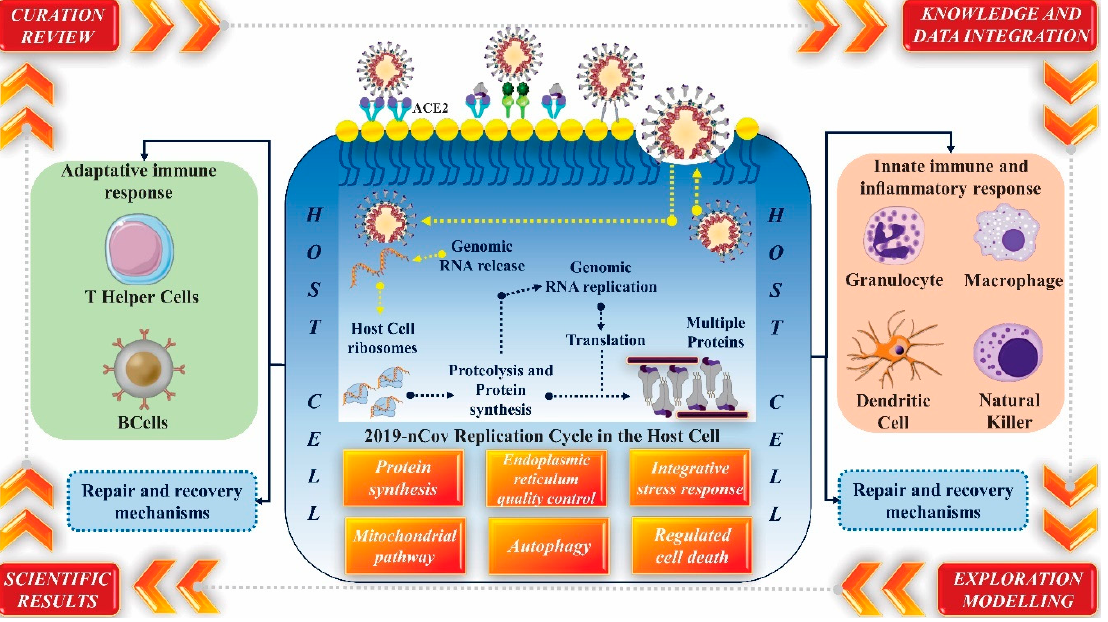
Figure 8. Overview of the functioning of the COVID-19 Disease Map: The map was created with a focus on the SARS-CoV-2 replication process, its interactions with host cells, immune system reactions, and repair mechanisms. According to the creators of the technology, the content inserted in the COVID-19 Disease Map is selected and reviewed from databases and knowledge continuously. This update is carried out according to the materials available in databases on the subject to support visual and computational exploration, as well as efforts to model diseases [137]. Note: This image was developed using the CorelDraw software (2017 Corel Corporation ID 410003).